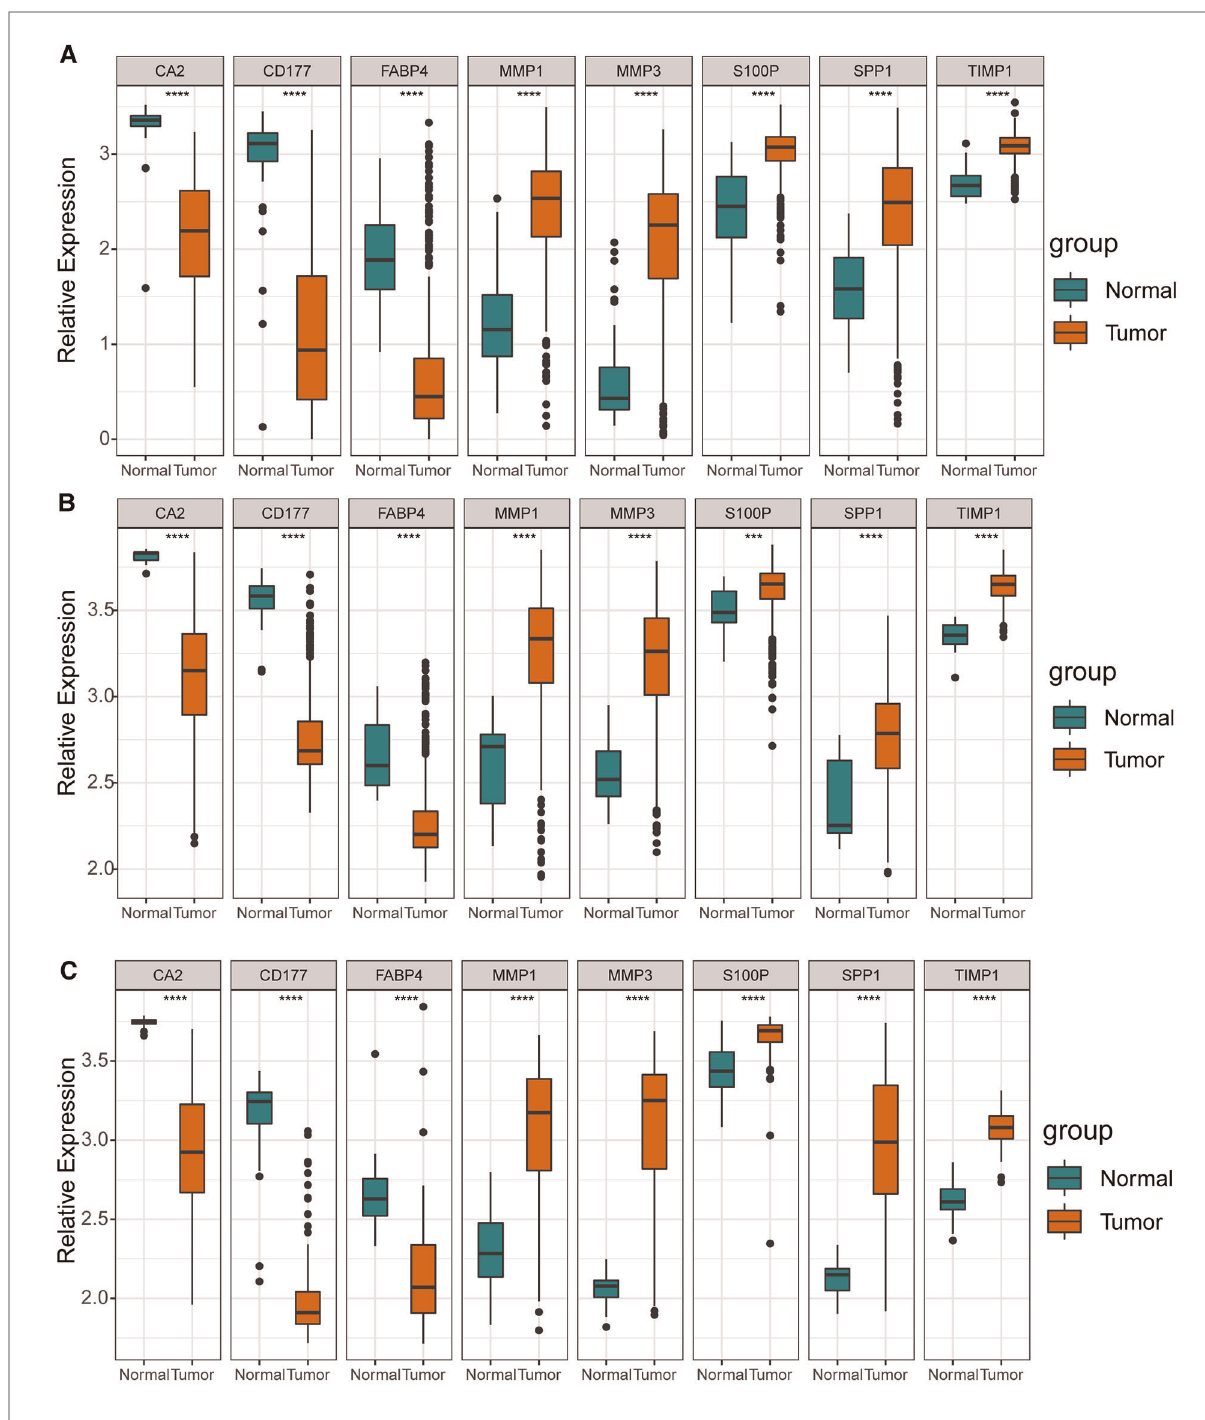
FIGURE 8 Expression levels of UC-related prognostic genes in three datasets. Expression levels of risk model genes in ( A ) TCGA-CRC, ( B ) GSE39582, and ( C ) GSE44076 datasets. **** p